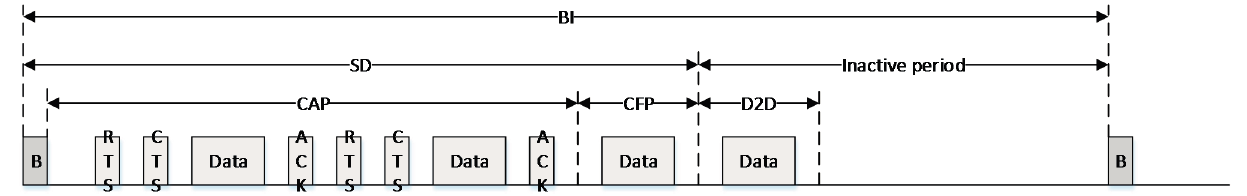
Figure 3. The proposed superframe